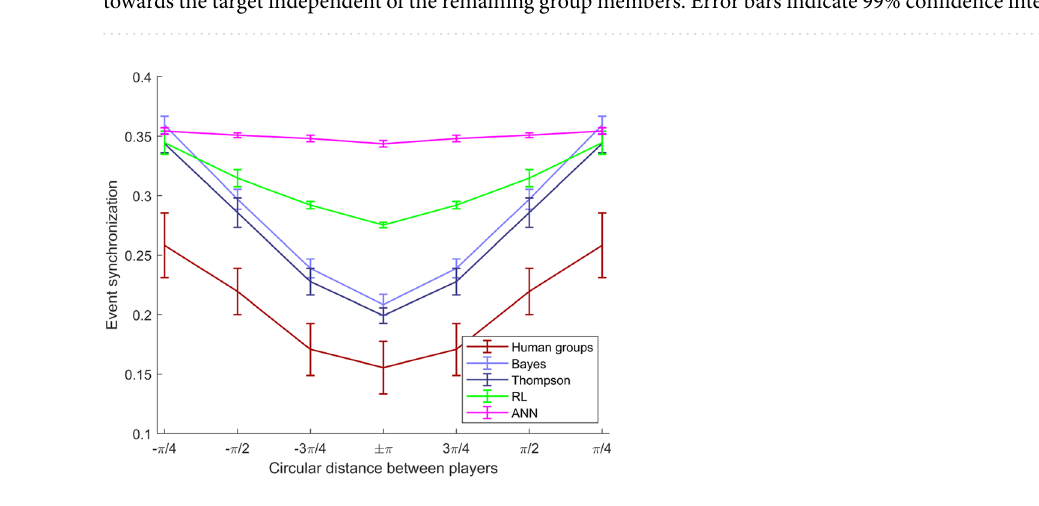
between actors that are paired with themselves. Naturally, this matrix is symmetric, as there are only 28 distinct pairs in total. To improve readability in Fig. 5, the players are arranged in the matrix in a way that reflects their